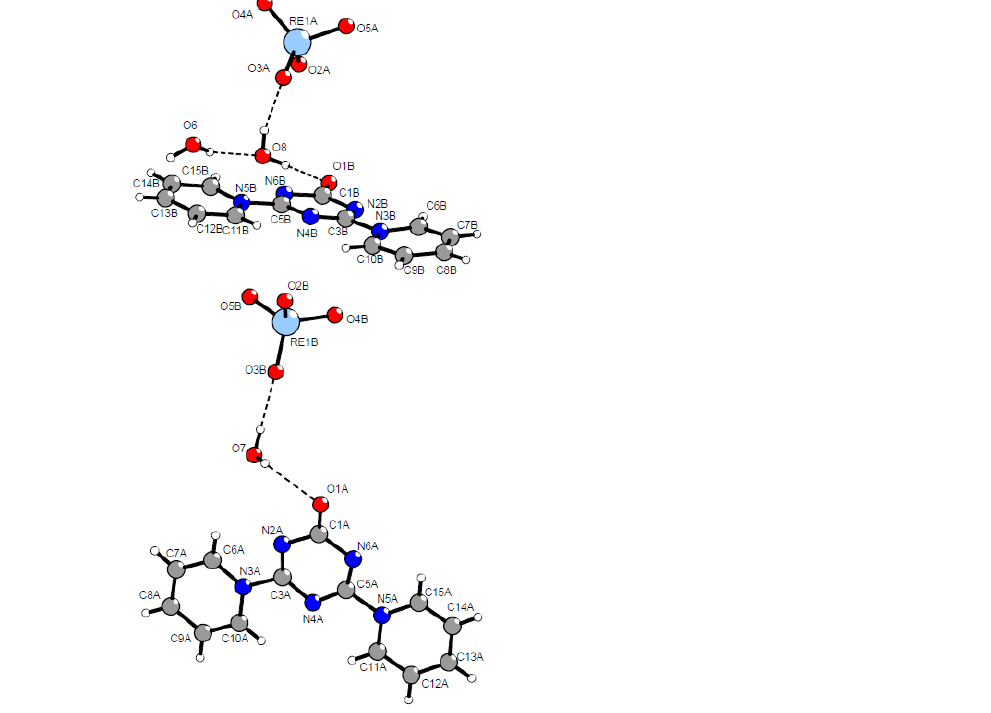
Figure 5. Numeration of atoms in the 4c ions. Displacement ellipsoids are drawn at a 30% probabil- ity level.